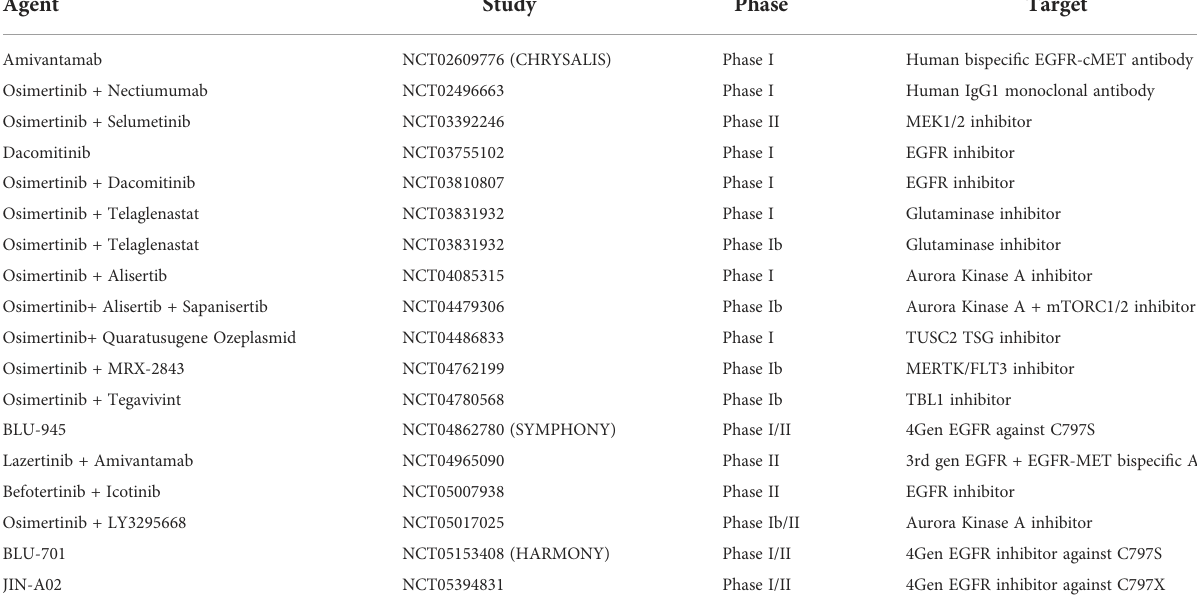
TABLE 1 Currently recruiting EGFR mutation non-small-cell lung cancer